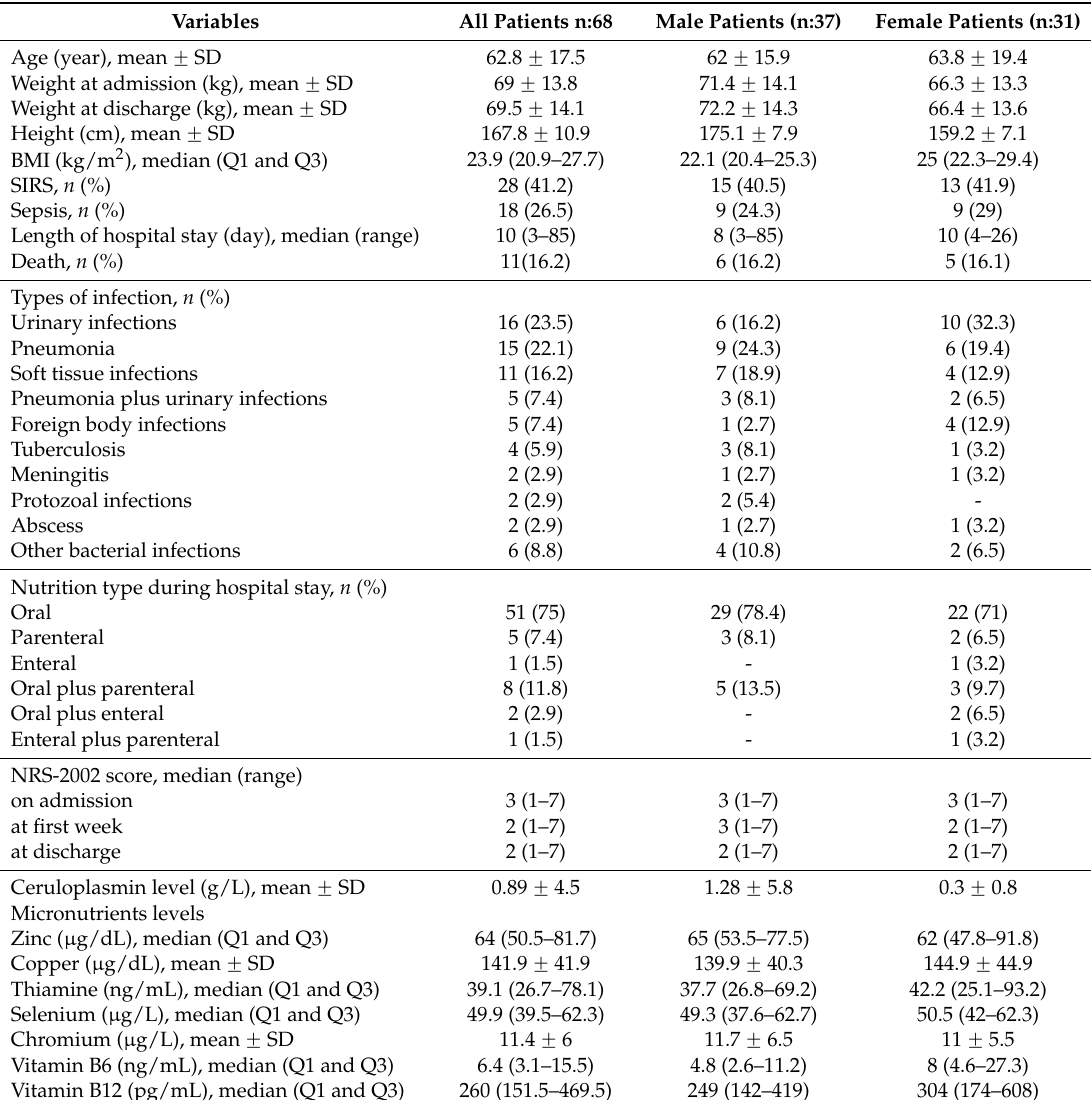
Table 1. The basic characteristics of the patients